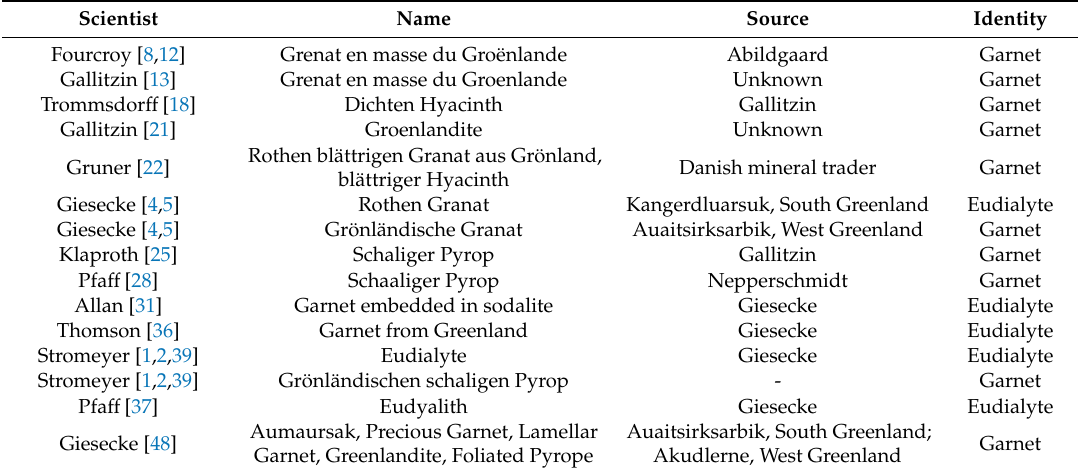
Table 2. Compiled list of names used by di ff erent scientists to denote greenlandite and eudialyte. Scientist Name Source